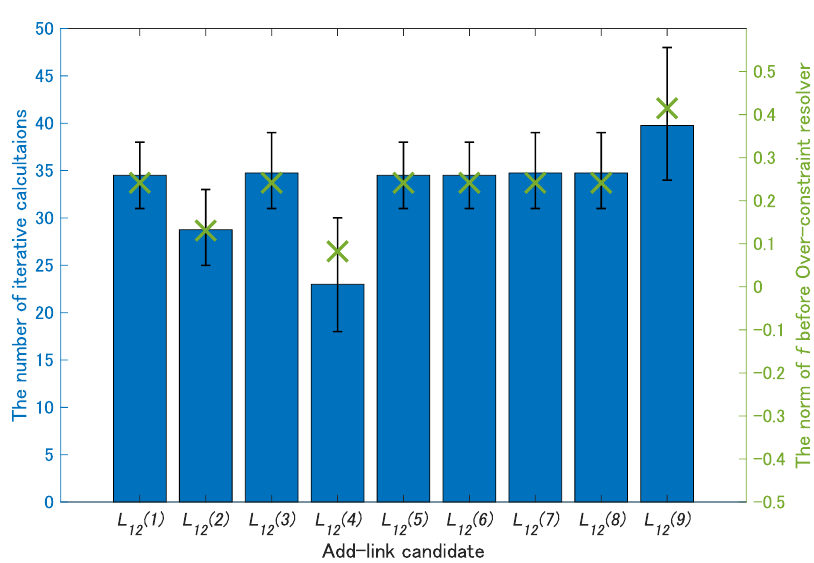
Figure 17. Iterative calculations and the norm of function values to obtain lengths of